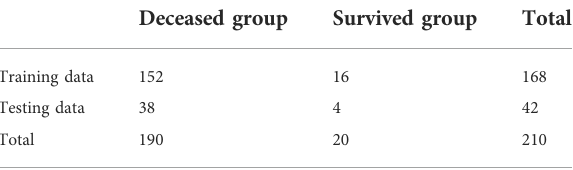
TABLE 3 Summary of training, validation, and testing